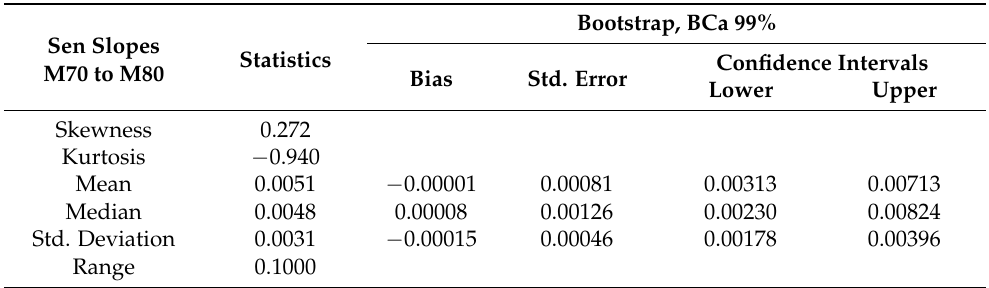
Table 12. Inferential statistics of Sen Slopes for inter decadal runoff difference between M70 and